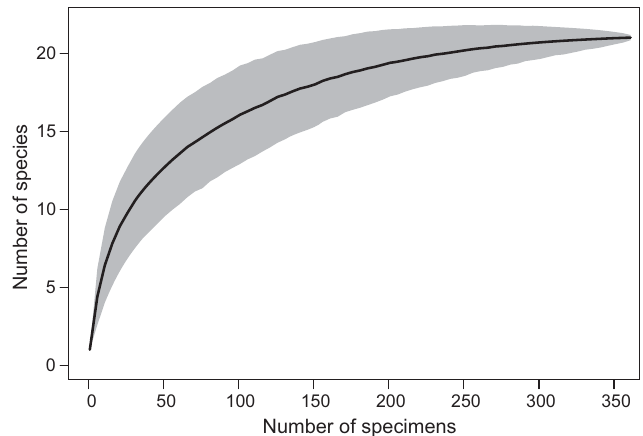
Fig. 4. Rarefaction curve (line in the middle) of the Chiampo sponge fauna at Lovara. Grey area demarcate 95% confidence intervals of diversity es- timates.